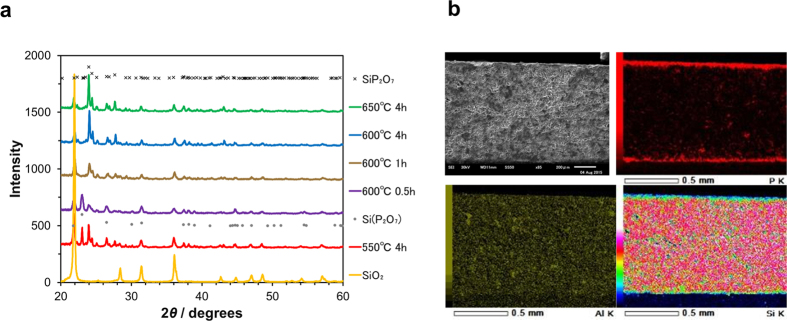
Characterization of Si1-xAlxHxP2O7-δ layer.(a) XRD patterns for Si0.97Al0.03O2-δ and Si1-xAlxHxP2O7-δ films and (b) SEM/EDX micrographs of a cross section of Si0.97Al0.03HxP2O7-δ/Si0.97Al0.03O2-δ composite.